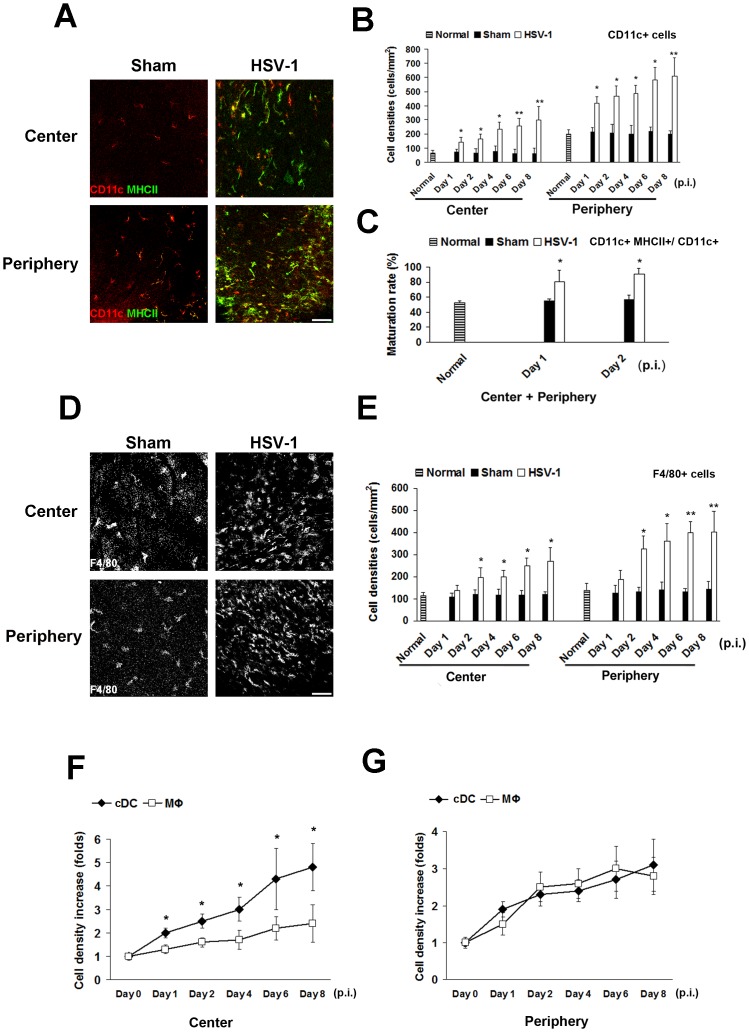
Herpes simplex keratitis results in significant increased conventional dendritic cell and macrophage density, as well as increased maturation of dendritic cells.Corneal inoculation was performed with HSV-1, or virus culture medium as sham controls, on days 1, 2, 4, 6, 8 p.i., Corneas (n = 5/time point) were excised and stained with antibodies against CD11c, F4/80, MHC-II; normal corneas were used as controls. A: Representative micrographs of CD11c (conventional dendritic cells [cDCs]) and MHC-II (maturation marker) expressing cells in the HSV-1 infected corneas compared with sham-infected corneas. B: As early as day 1 p.i., cDC densities of central and peripheral corneas were significantly increased as compared to sham controls, and continuously increased on days 2, 4, 6, 8 p.i. C: cDC maturation (CD11c+MHC-II+/total CD11c+) after HSV-1 infection significantly increased vs. sham controls. D: Representative micrographs of F4/80 expressing cells (macrophages [MΦs]) in HSV-1 infected corneas compared with sham controls. E: MΦ density were significantly increased in central and peripheral corneas after HSV-1 infection as compared to sham controls on days 2, 4, 6, 8 p.i. F, G: The relative increase in density (density after HSV infection /density after sham infection) of cDC was significant higher than the relative increase in MΦ density in central corneas on days 1, 2, 4, 6, 8 p.i., while no significant differences were found in peripheral corneas. Each experiment was replicated three times. *p<0.05, **p<0.01 compared to sham controls (Student’s t-test, two-sided); data are shown as mean ± SD. Scale bar: 100 μm.